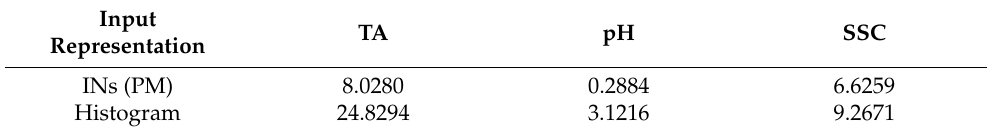
Table 3. Comparative results (MSE) for two input representations: raw histogram and induced INs